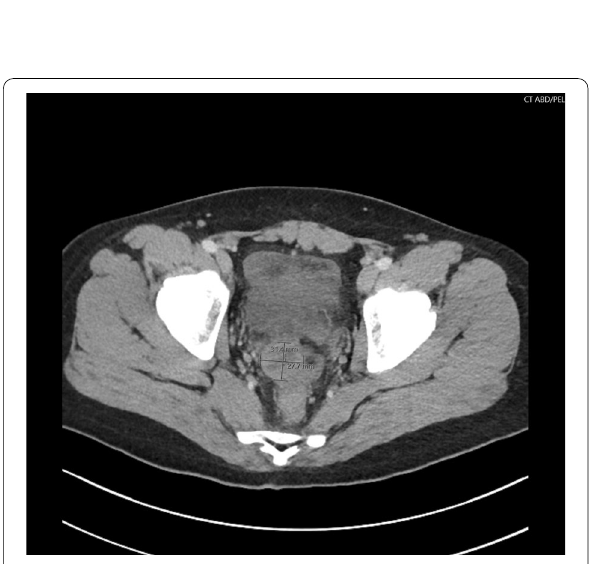
Fig. 2 Transverse view of the abdominal CT demonstrating 31.4 27.7‑cm appendiceal abscess by the appendiceal tip in the ×